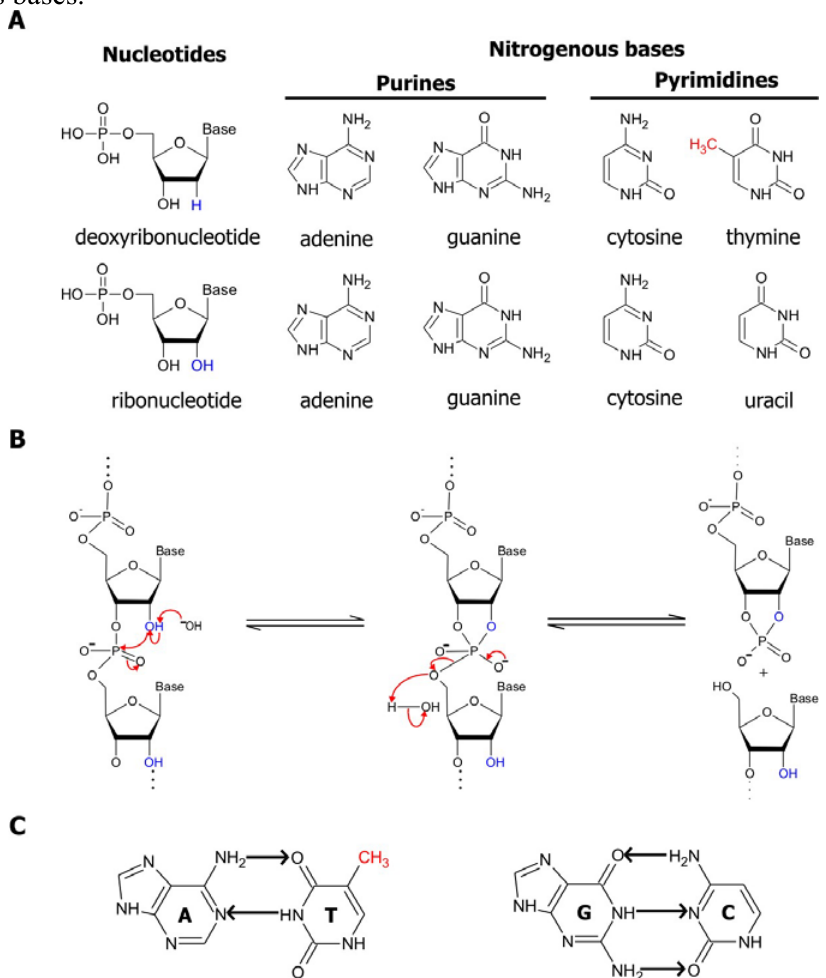
Figure 1. Properties of nucleic acids. a) The structures of deoxyribonucleotides and ribonucleotides, the building blocks of DNA and RNA, are illustrated. b) Pathway of base- mediated degradation of RNA. c) Hydrogen bonding between purine and pyrimidine nitrogenous